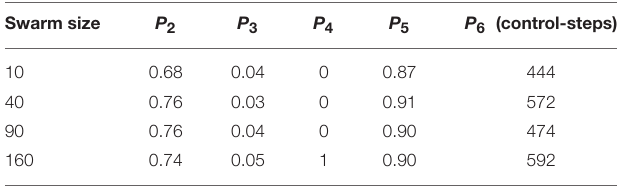
TABLE 1 | Performance of system for swarms of varying sizes.